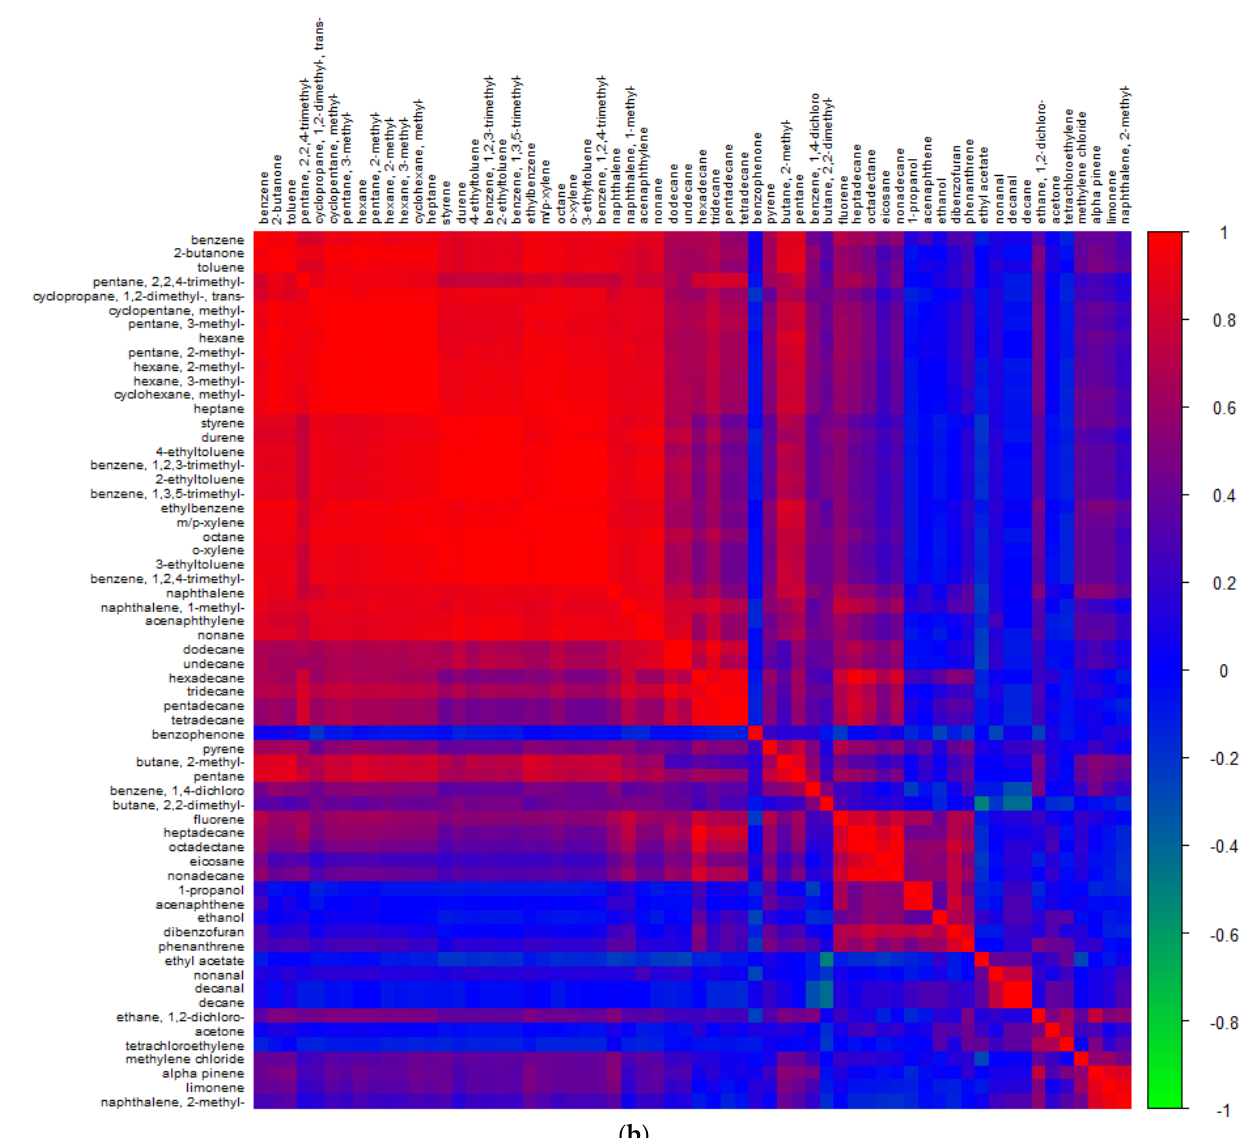
Figure 5. Pearson correlation coefficients for target VOCs measured that were above LOD in ( a ) Nairobi air and ( b ) Lagos air, displayed with hierarchical clustering.